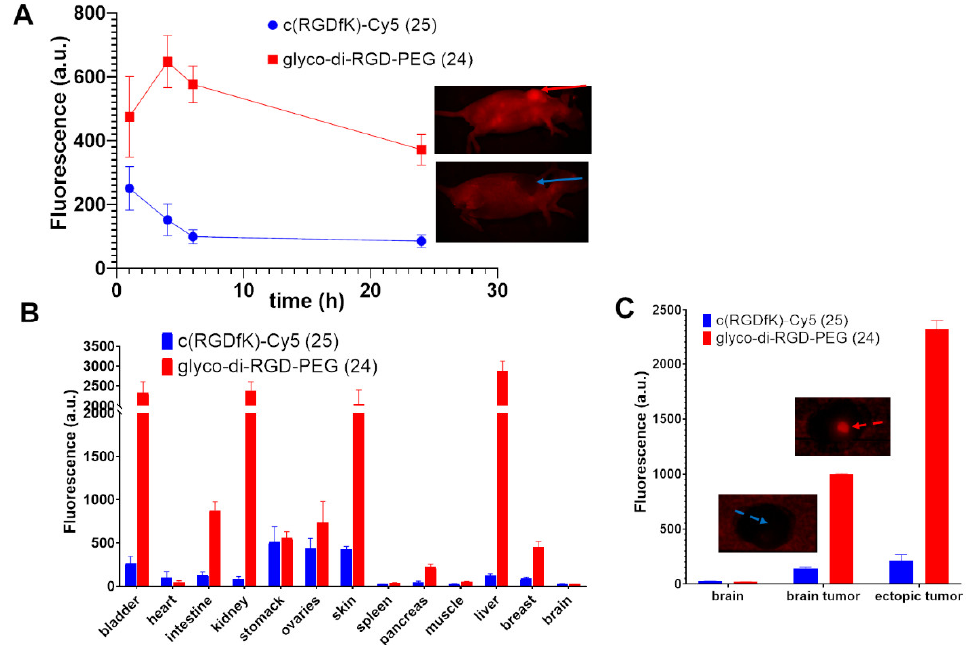
Figure 4. Biodistribution of compounds 24 and 25 in tumors and organs. ( A ) Kinetic distribution of compounds 24 and 25 in ectopic U-87 MG tumors at 1, 4, 6, and 24 h (representative images of the whole mice with the solid arrows showing the ectopic tumors at 24 h). ( B ) Biodistribution of the compounds in major organs at 24 h after their administration. ( C ) Brain and orthotopic and ectopic brain tumor distributions after 24 h of administration. An average of ratio uptake was calculated. Representative images of the brain with the dotted arrows showing the intracranial tumors at 24 h.